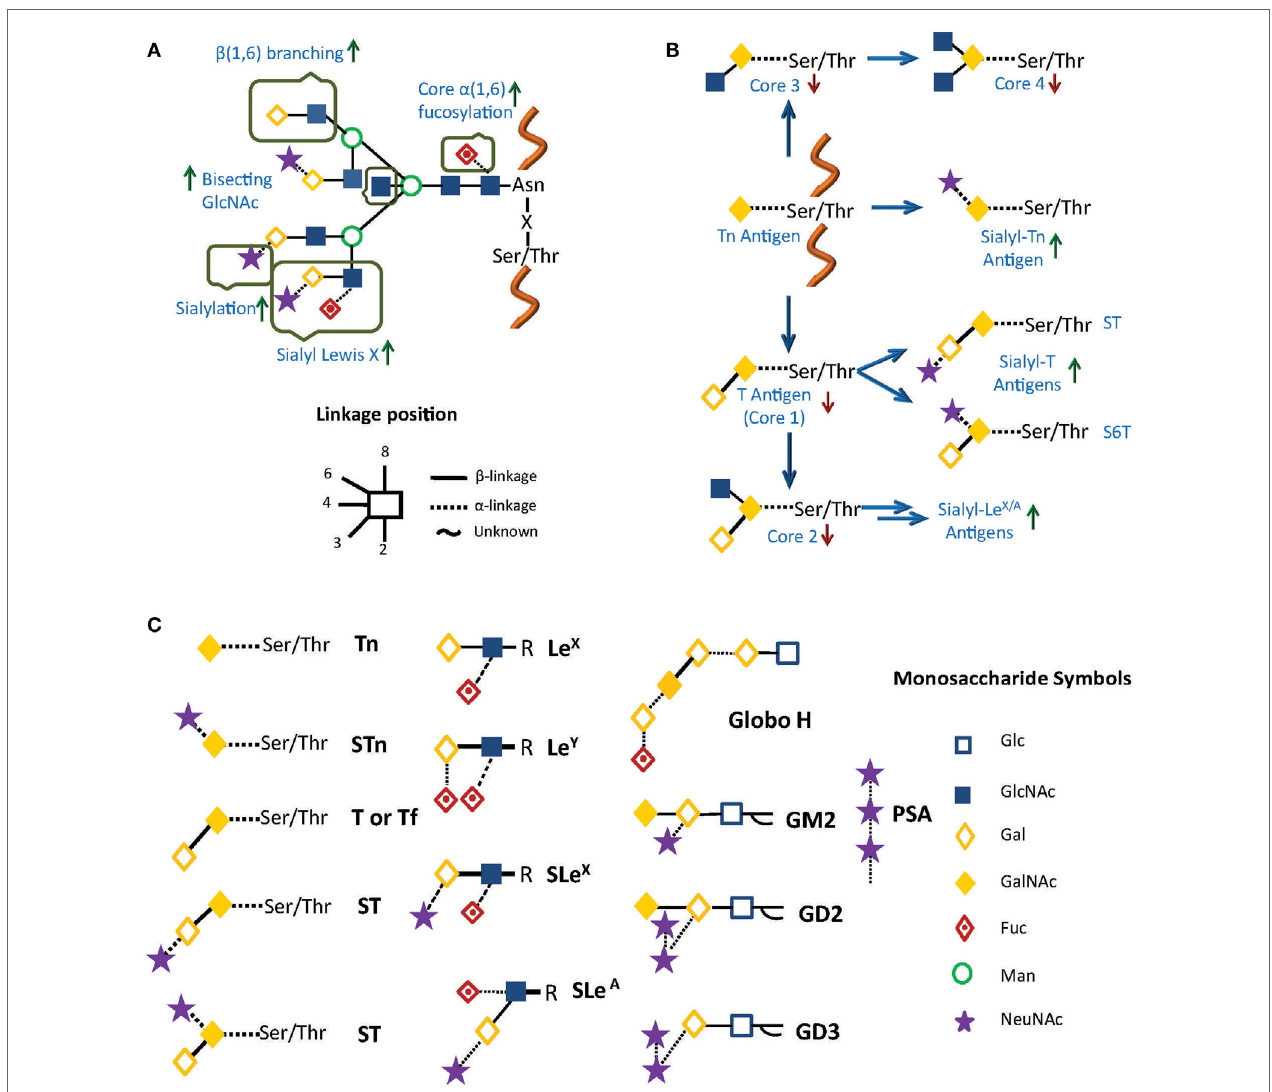
FiGURe 1 | Common alterations observed in cancer in (A) N -glycosylation and (B) O -glycosylation . Green and red arrows represent increased and decreased expression of glycan structures, respectively. (C) Principal tumor-associated carbohydrate antigens (TACAs). In all cases, glycans are represented using a combination of the Oxford (21) and the Consortium for Functional Glycomics formats